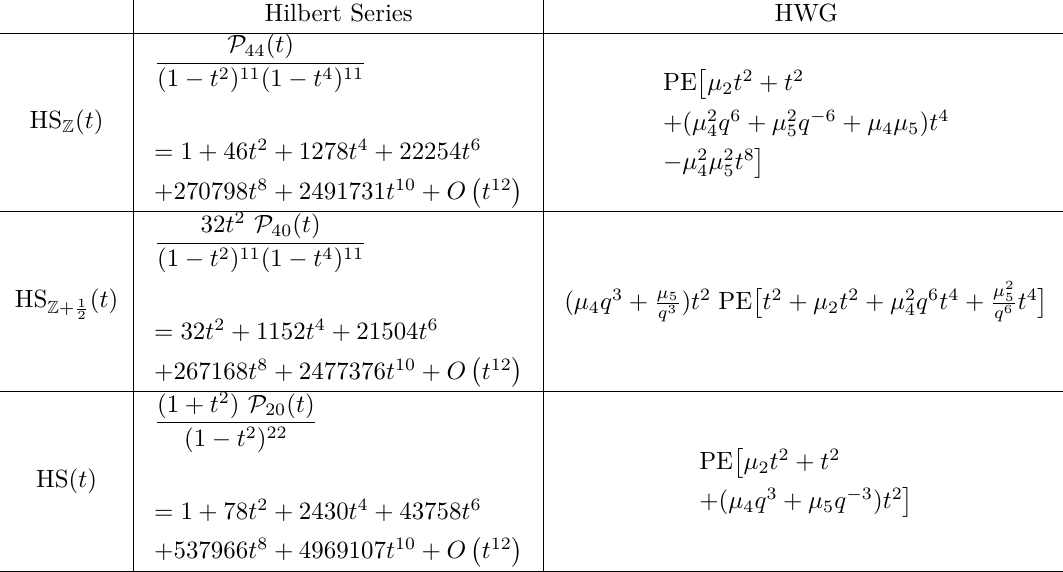
Table 9. Hilbert series for the E 6 magnetic quiver (3.5). The first line of the table provides the Hilbert series when the GNO magnetic lattice is integer HS Z ( t ) , the second line shows the sum over the integers-plus-half lattice HS Z ( t ) and the last line is their sum HS( t ) . The palindromic + 1 2 numerator terms P k ( t ) are given in appendix E. In the third column, we show the HWGs in terms of fugacities for so (10) (denoted µ 1 , . . . , µ 5 ) and u (1) (denoted q ). Note that the q -charge is